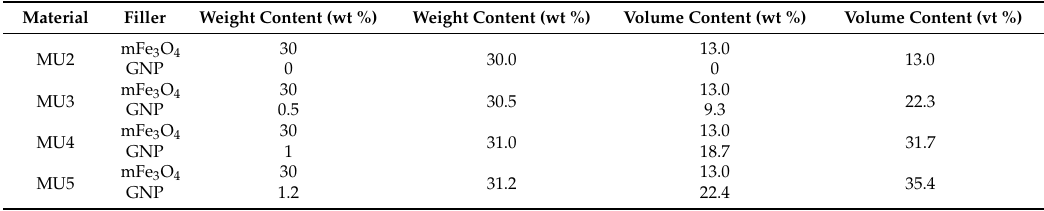
Figure 12. The amount of fillers added to adequate composites, from top left: MU2, MU3, MU4 and MU5. Table 5. The weight and volume amount of fillers in composites